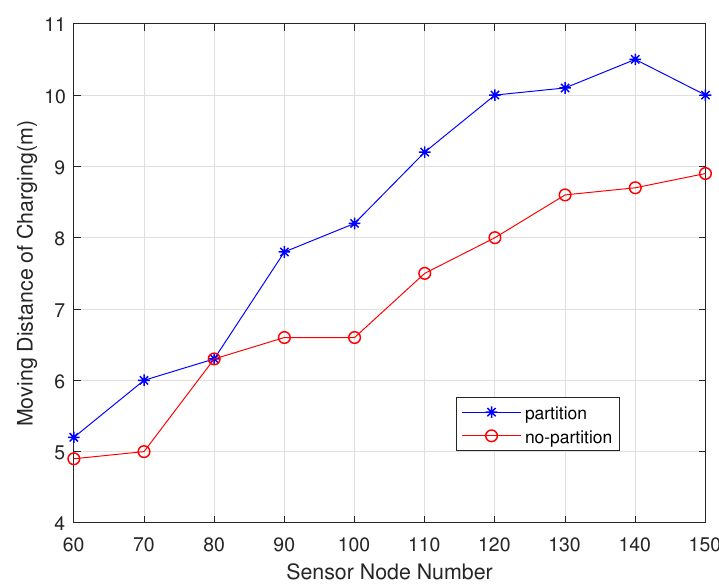
Figure 17. Moving distance of charger varies with sensor node